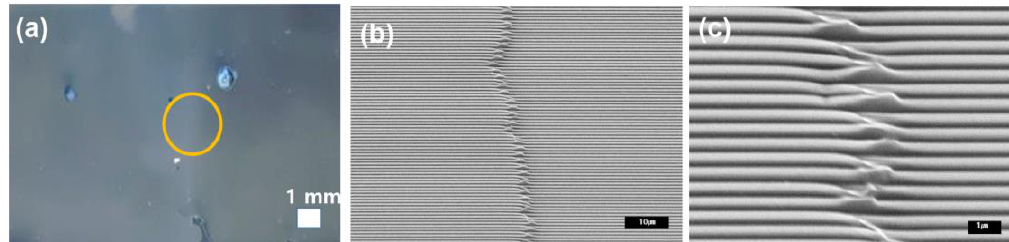
Figure 5. ( a ) A picture of the tiling next to the defined structures. The circle represents the boundary between the two tiles. ( b ) An SEM image of the boundary region. ( c ) A magnified image of ( b ). The defects (merged lines) cover 2~3 µm, although the boundary is almost invisible.